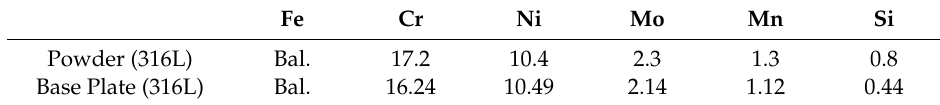
Table 1. Powder and base plate Steel 316L chemical composition (wt. %).